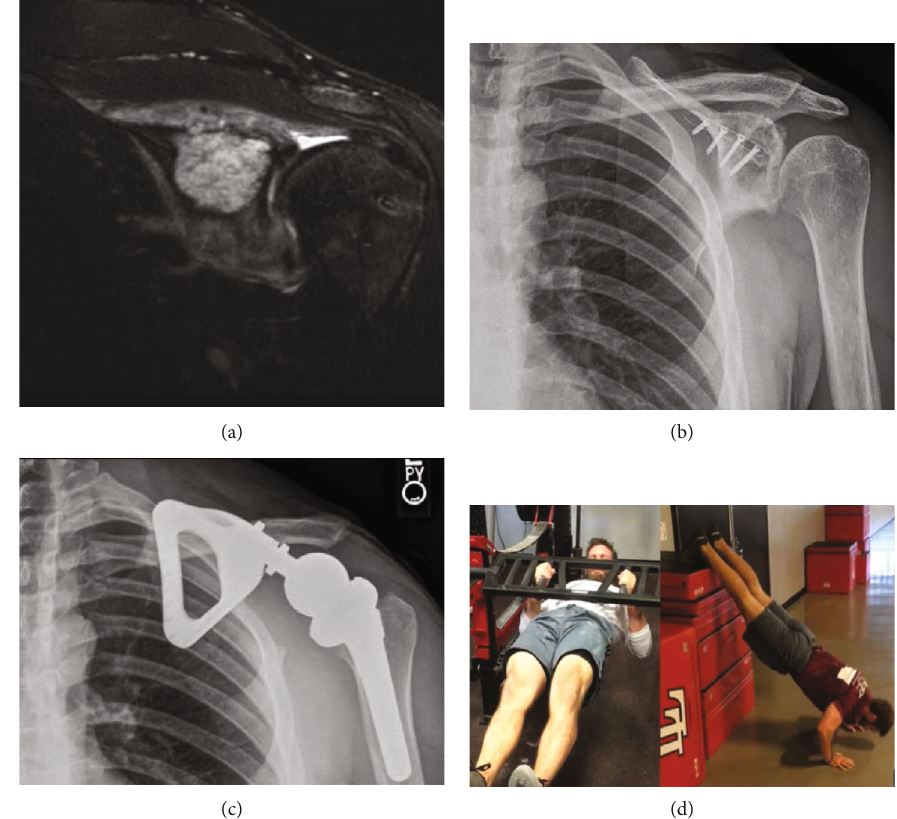
Figure 2: (a) MRI demonstrating malignant lesion of the scapula involving the subglenoid region of the shoulder. (b) Shoulder radiograph after index surgery which involved intralesional curettage, cryosurgery, grafting, and prophylactic internal fi xation of the left glenoid. (c) Three-year postoperative radiograph after shoulder reconstruction. (d) Patient performing cross- fi t activities